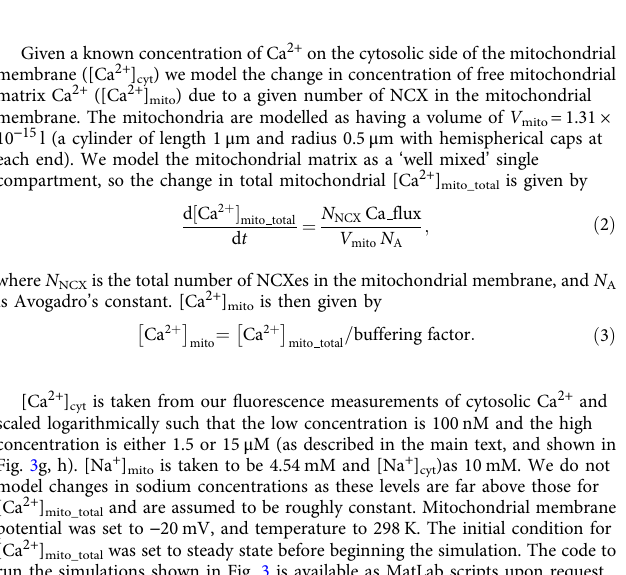
Table. Mathematical modelling . We denote concentrations with square brackets, e.g. '[Ca 2+ ]', and free mitochondrial matrix or cytosolic ion concentrations with the subscripts ‘ mito ’ or ‘ cyt ’ , respectively. We extended a model of NCX by Kim and Matsuoka 9 to model the accumulation/depletion of Ca 2+ within the mitochondrial matrix. The Kim and Matsuoka model predicts the net Ca 2+ fl ux in ions per second through a single NCX, and can be written as a single function ‘ f ’ : (cid:1) Ca flux ¼ f Ca 2 þ